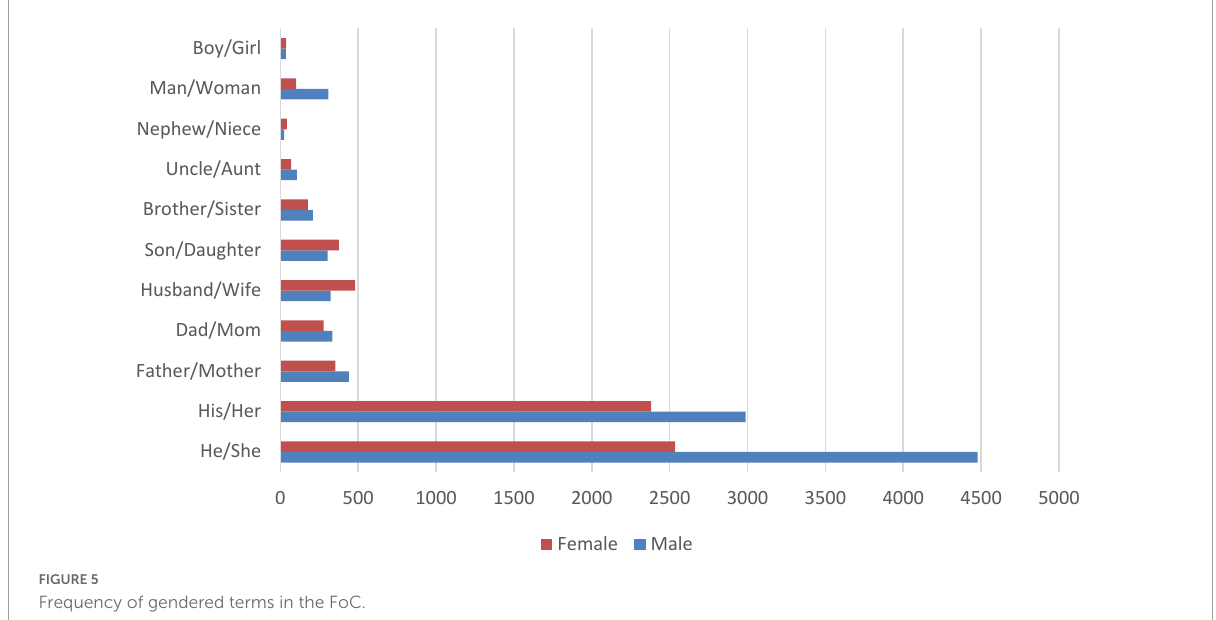
FIGURE5 Frequency of gendered terms in the FoC.